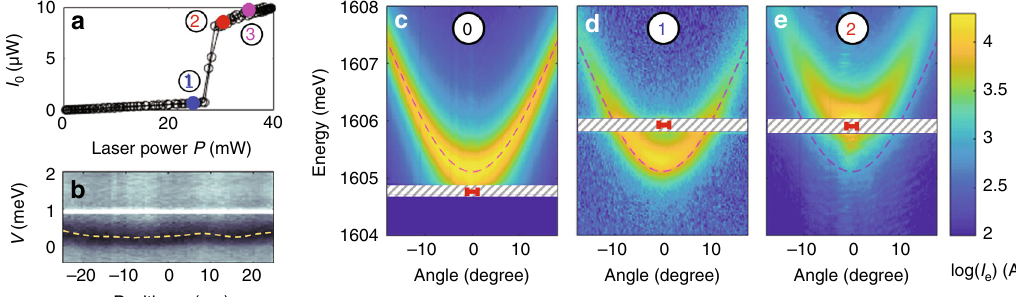
Fig. 2 Characterization and resonant photoluminescence of WPA. a Measured cross-polarized polaritonic emission intensity I 0 vs laser power P . b Color- scaled microre fl ectivity measured across the working poin. The black area is the polariton absorption dip. The white streak is due to residual laser light. The orange dashed line shows the extracted potential V ð x ; y Þ across the working point. Angle and energy-resolved cross-polarized EPL measurements I ð θ ; _ ω Þ in the free-particle regime ( c ), in the lower branch of I ð P Þ ( d ), in the upper branch ( e ). The intensity is color coded on a logarithmic scale. The 0 e p hatched rectangles show the spectral range rejected by the notch fi lter. The laser energy and angular spread are shown as a red segment. WPA is characterized by δ ¼ þ 1 : 2 5 meV